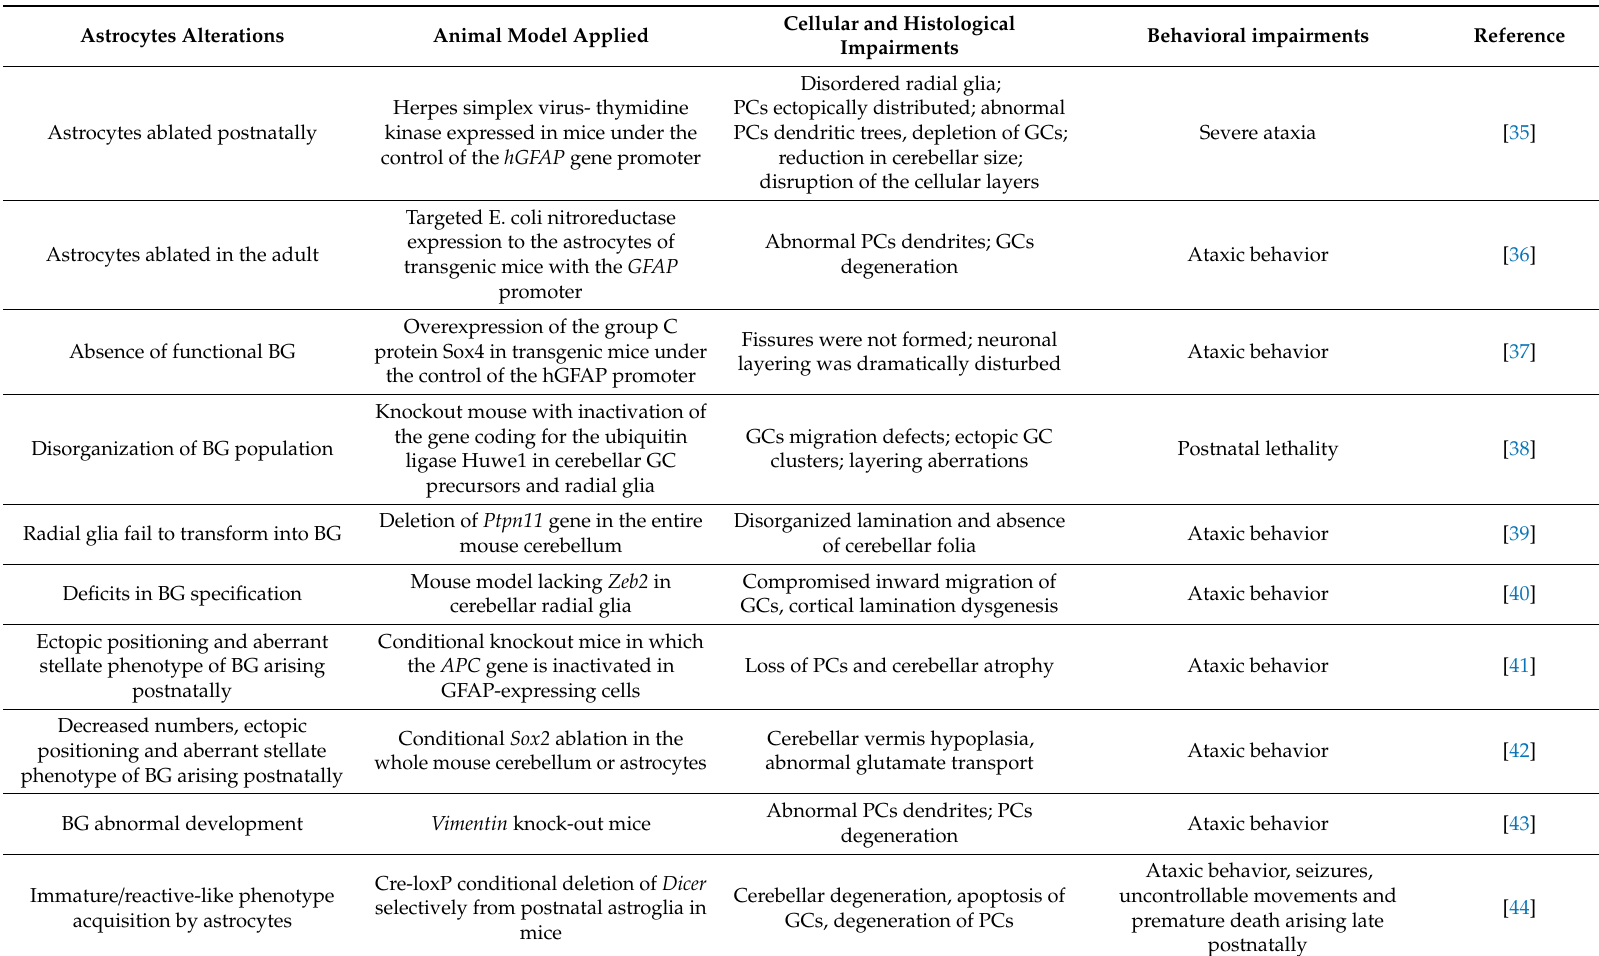
Table 1. Astrocytes developmental or functional deficiencies result in neuronal degeneration and / or motor